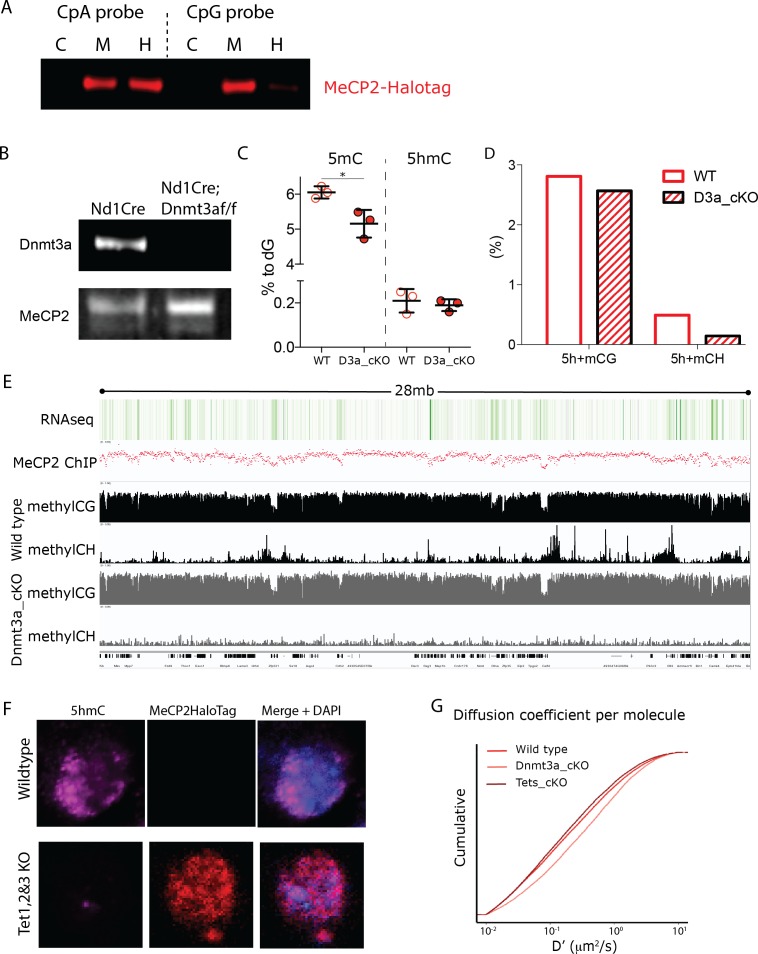
Cerebellar Granule cells lacking Dnmt3a or Tet1, Tet2 and Tet3 expression result in altered DNA methylations levels.Dnmt3a-flox animals were crossed with Neurod1-cre animals to conditionally deplete Dnmt3a from cerebellar granule cells. (A) Western blot of MeCP2-HaloTag following DNA pull-down of whole protein nuclear extracts from transfected 293 cells. CpA and CpG synthetic DNA probes were designed to carry Cs only in CA or CG contexts, respectively. C, DNA probe is unmodified; M, 5mC in DNA probe; H, 5hmC in DNA probe. (B) Western blot for Dnmat3a of protein extraction from Granule cell nuclei isolated from adults (~3 months old) Neurod1-cre (Wild-type) or Neurod1-cre; Dnmt3aflox/flox Dnmt3a conditional Knockout). MeCP2 was used as a loading control. (C) Mass spectrometry analysis of genomic DNA from Granule cell nuclei isolated from adults (~3 months old) Nurod1-cre (WT) or Neurod1-cre;Dnmt3aflox/flox (D3a_cKO), where 5-methylCytosines (5mC) and 5hydroxyMethylaCytosines (5hmC) were quantified as proportion to Guanosines (% to dG). (D) Whole-genome bisulfite (WGB) sequence of genomic DNA was used to quantify the cytosine modifications (5-methyl-cytosine or 5-hydroxy-methyl-cytosine, 5h+m) in its different sequence context (CG or CH – where H = A, T or C-) in wild type (WT) or Dnmt3a depleted Granule cells (D3a_cKO). (E) A snapshot of the IGV viewer displaying RNA-seq and MeCP2 ChIP-seq in adult cerebellar Granule cells (top) and WGB-seq traces of CG and CH loci in Wild-type or Dnmt3a depleted granule cells (Dnmt3a_cKO). (F) Immunostaining for 5hmC in Tet1flox/flox;Tet2flox/flox; Tet3flox/flox GC culture co-transfected with Cre-expressing and DIO-MeCP2-HaloTag constructs. HaloTag positive cells (red) were successfully transfected with the Cre expressing construct and are therefore devoid of 5hmC (purple). (G) Cumulative distribution of diffusion coefficient (D’, μm2/s) calculated for individual molecules of MeCP2 in wild type (~25,000 molecules, solid red), Dnmt3a depleted (~12,000 molecules, light red) or lacking Tet1, 2 and 3 granule cells (~14,000 molecules, dark red).